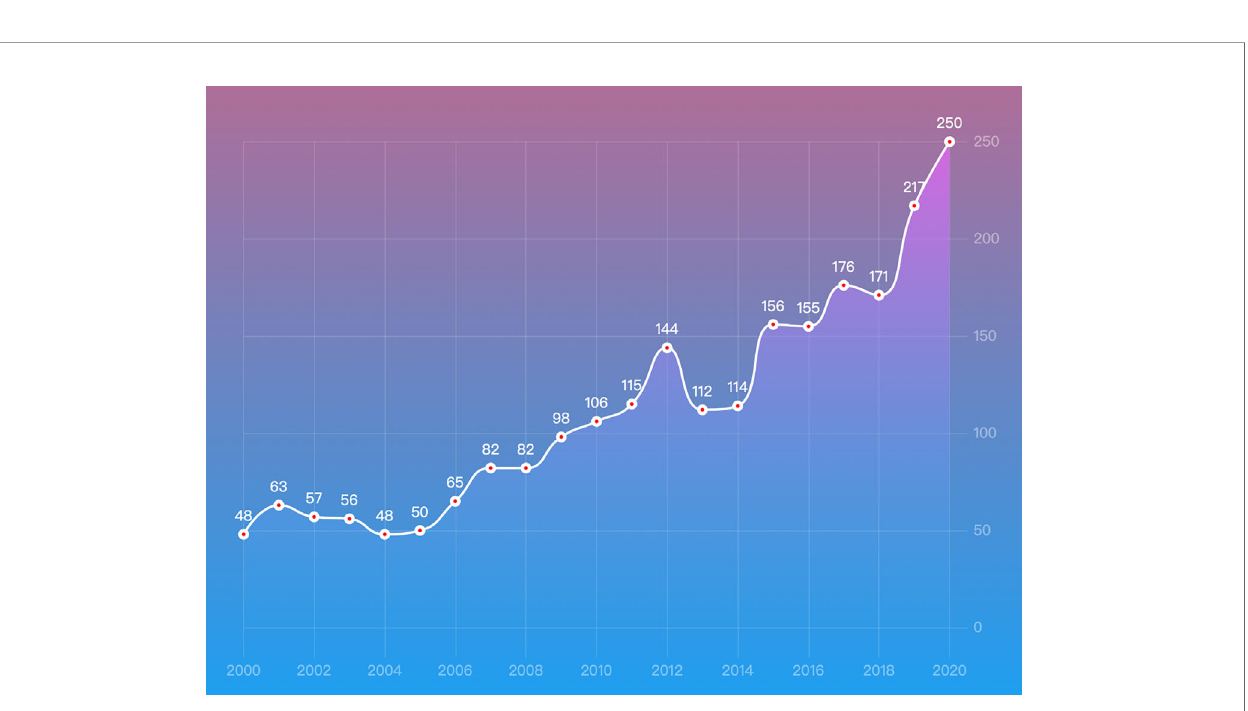
FIGURE 2 | Annual number of the published publications in PA research from 2000 to 2020.